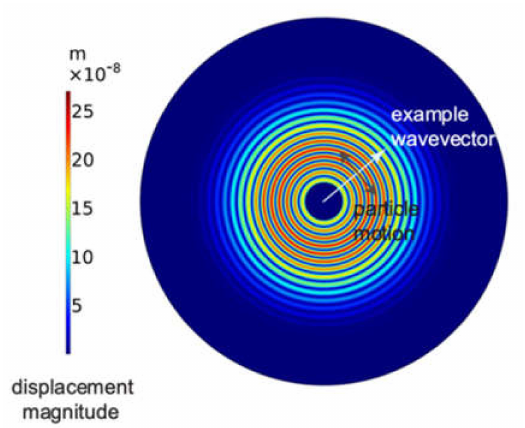
Figure 1. An omni-directional shear transducer located at the center of an isotropic plate generates circular-crested shear-horizontal waves that are axisymmetric. An example wave vector and the associated particle displacement are marked.